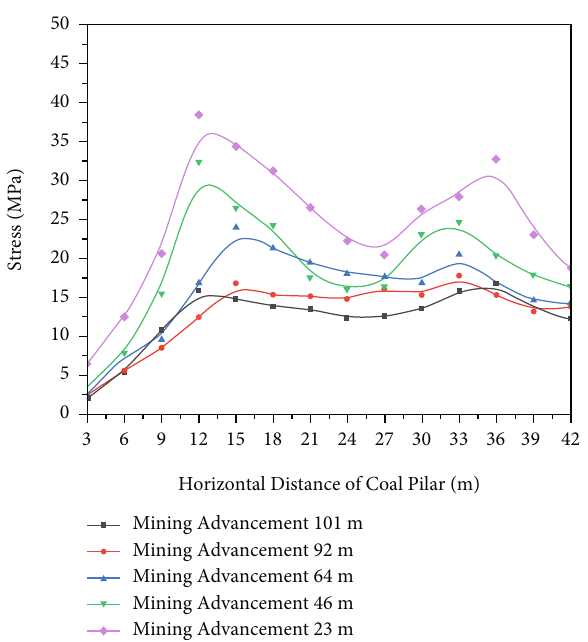
Figure 7: Distribution diagram of lateral abutment pressure in the coal The vertical stress distribution data obtained by numer- ical simulation is plotted as curves (Figure 10).